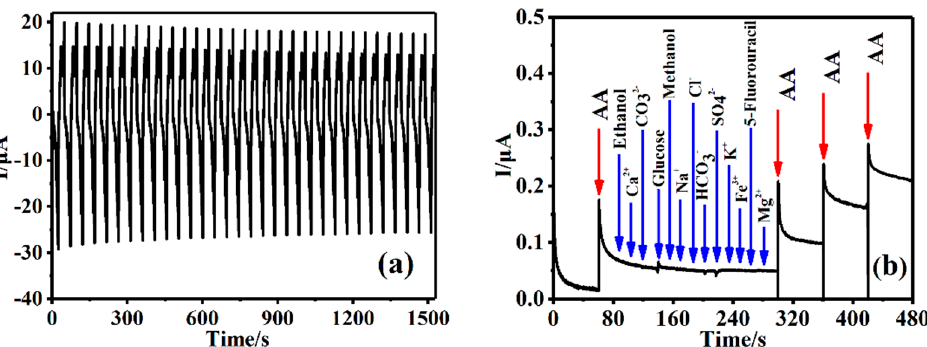
Figure 10. ( a ) CV of Cu-TCPP@MOFs/GCE in 0.3 mM AA solution for 32 cycles (n = 32). ( b ) Amperometric I-t curve of Cu-TCPP@MOFs/GCE for addition of AA and each 500 μ M of potentially interferents, in 0.1 M PBS (pH = 7.0) (applied potential was 0.1 V).